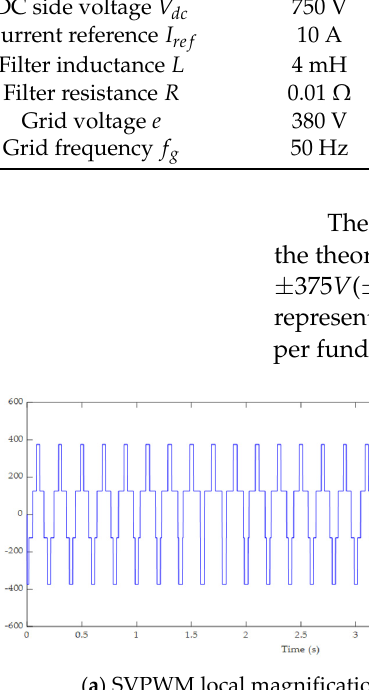
Figure 11. CMV under different strategies.